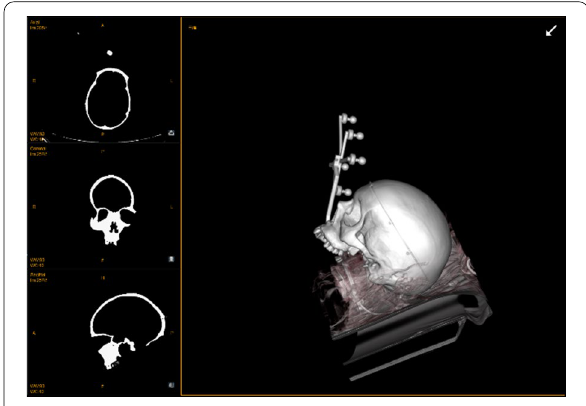
Figure 7 3D image, axial, sagittal and coronal plane in C